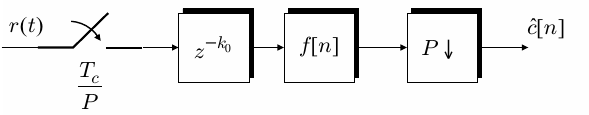
Figure 3. Chip based fractionally spaced